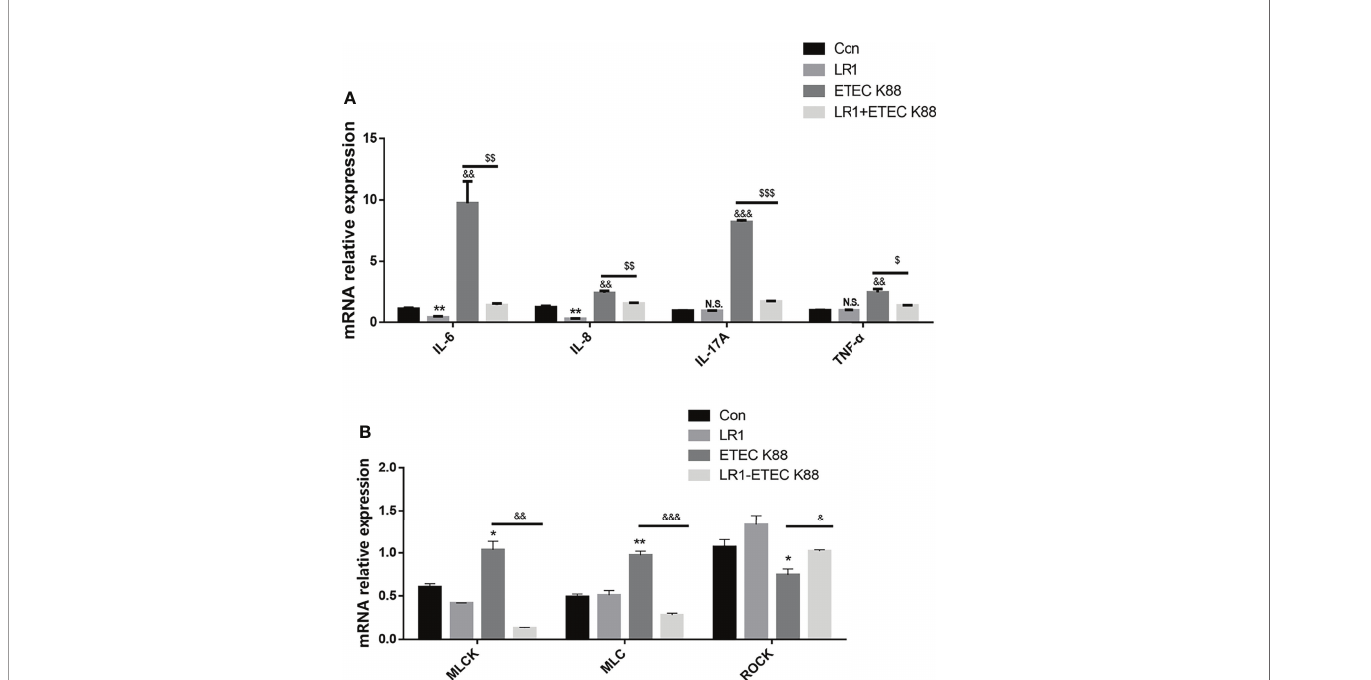
FIGURE 5 | Effects of L. reuteri LR1 on in fl ammatory cytokine expression and MLCK signal pathway expression in IPEC-J2 cells treated with ETEC K88. (A) The effects of L. reuteri LR1 (1 × 10 9 cfu/ml) on IL-8, IL-17A, IL-6, and TNF- a gene expression in IPEC-J2 cells treated with ETEC K88 (1 × 10 8 cfu/ml). Cells were treated with L. reuteri LR1 (1 × 10 9 cfu/ml) for 4 h, and then followed by ETEC K88 (1 × 10 8 cfu/ml) for 4 h. Data presented as mean ± SEM ( n = 3). (B) The effects of L. reuteri LR1 (1 × 10 9 cfu/ml) on MLCK, MLC, and ROCK gene expression in IPEC-J2 cells treated with ETEC K88 (1 × 10 8 cfu/ml). Cells were treated with L. reuteri LR1 (1 × 10 9 cfu/ml) for 4 h, and then followed by ETEC K88 (1 × 10 8 cfu/ml) for 4 h. Data presented as mean ± SEM ( n = 3). * p < 0.05, ** p < 0.01, and *** p < 0.001 vs. the control group; & p < 0.05, && p < 0.01, and &&& p < 0.001 vs. the control group; $ p < 0.05, $$ p < 0.01, and $$$ p < 0.001 vs. the ETEC K88 group. N.S., not signi fi